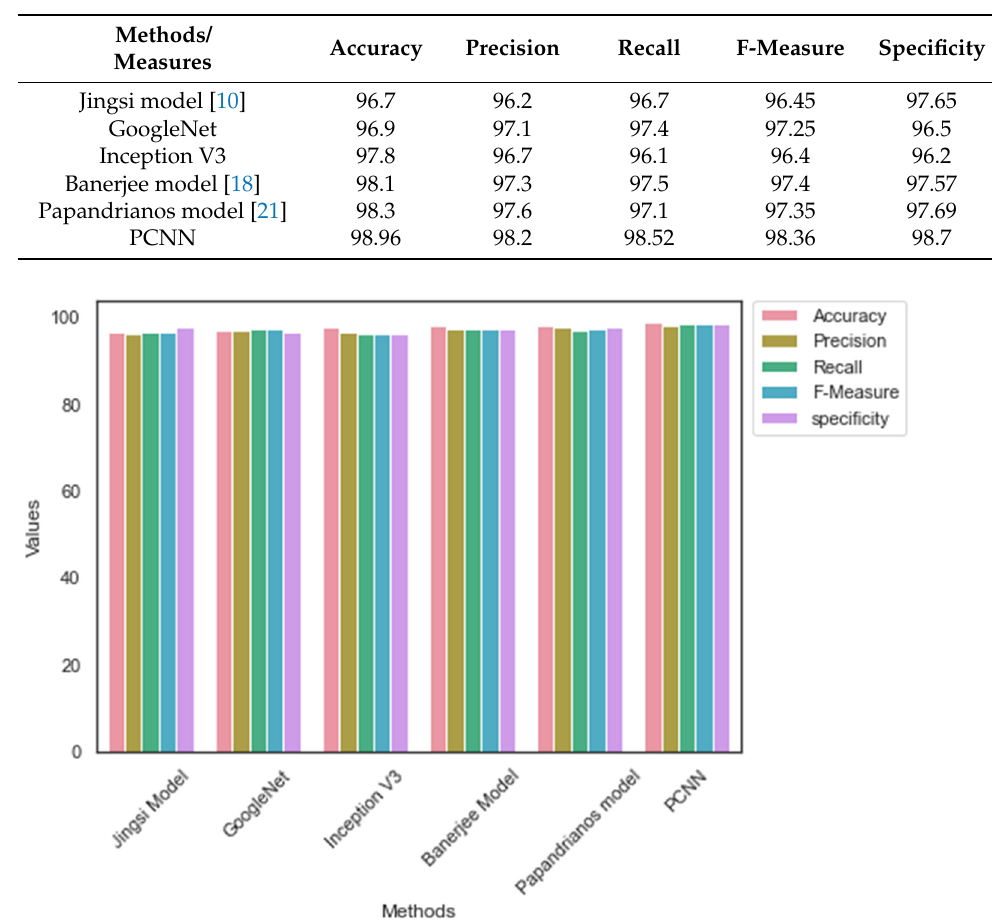
Figure 8. Comparative analysis outcome: Dataset_1.